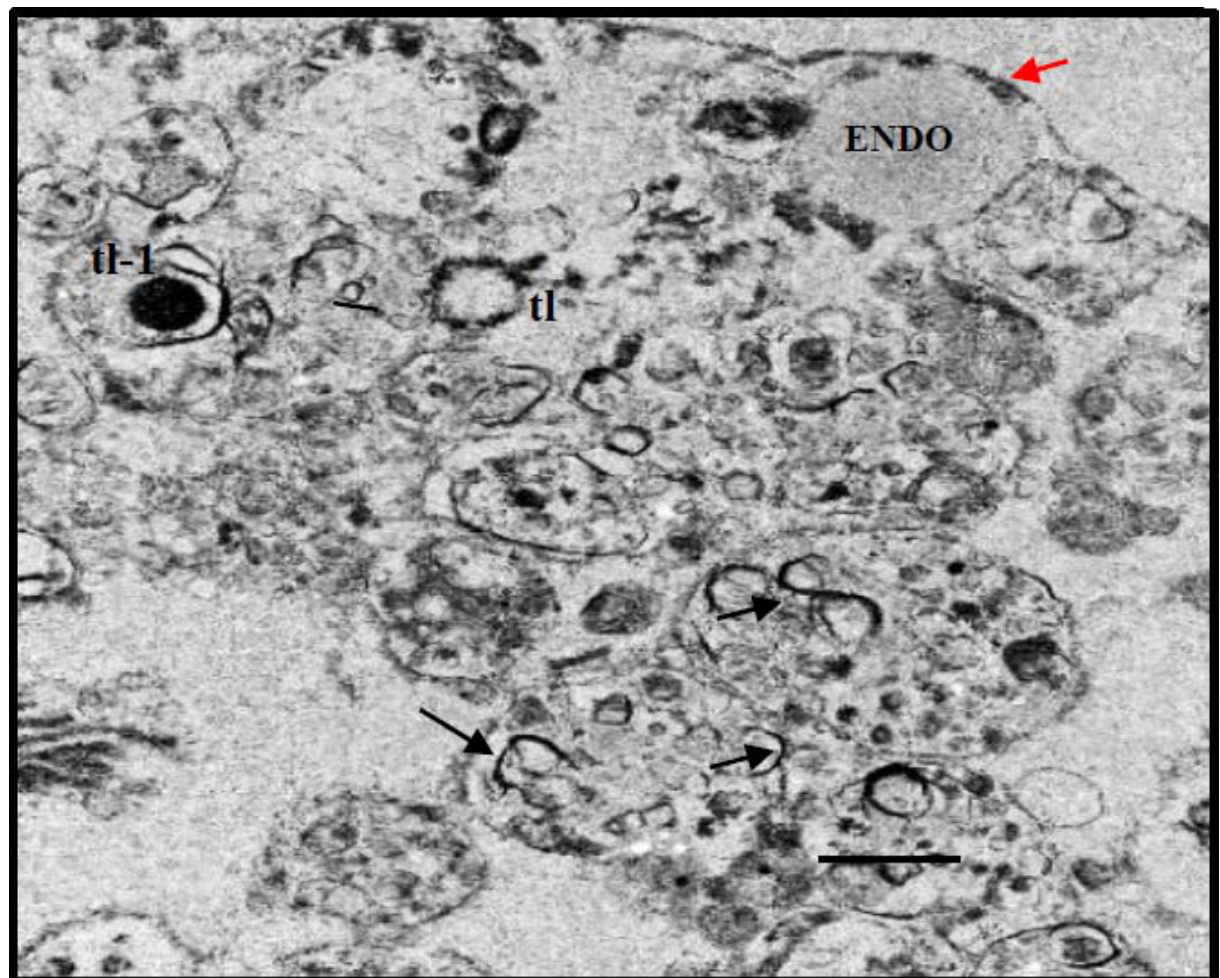
Figure 11. Transmission electron micrograph of a large granular BmVIII-SCC cell on day 85 of culture with gelatinous beads in bioreactor showing membrane-bound cytoplasmic vacuoles with granular material (black arrow), tubular lysosomes (TL), and a large endosome containing electron ‐ dense material (ENDO, red arrow) (Scale bar = 1 μ m).